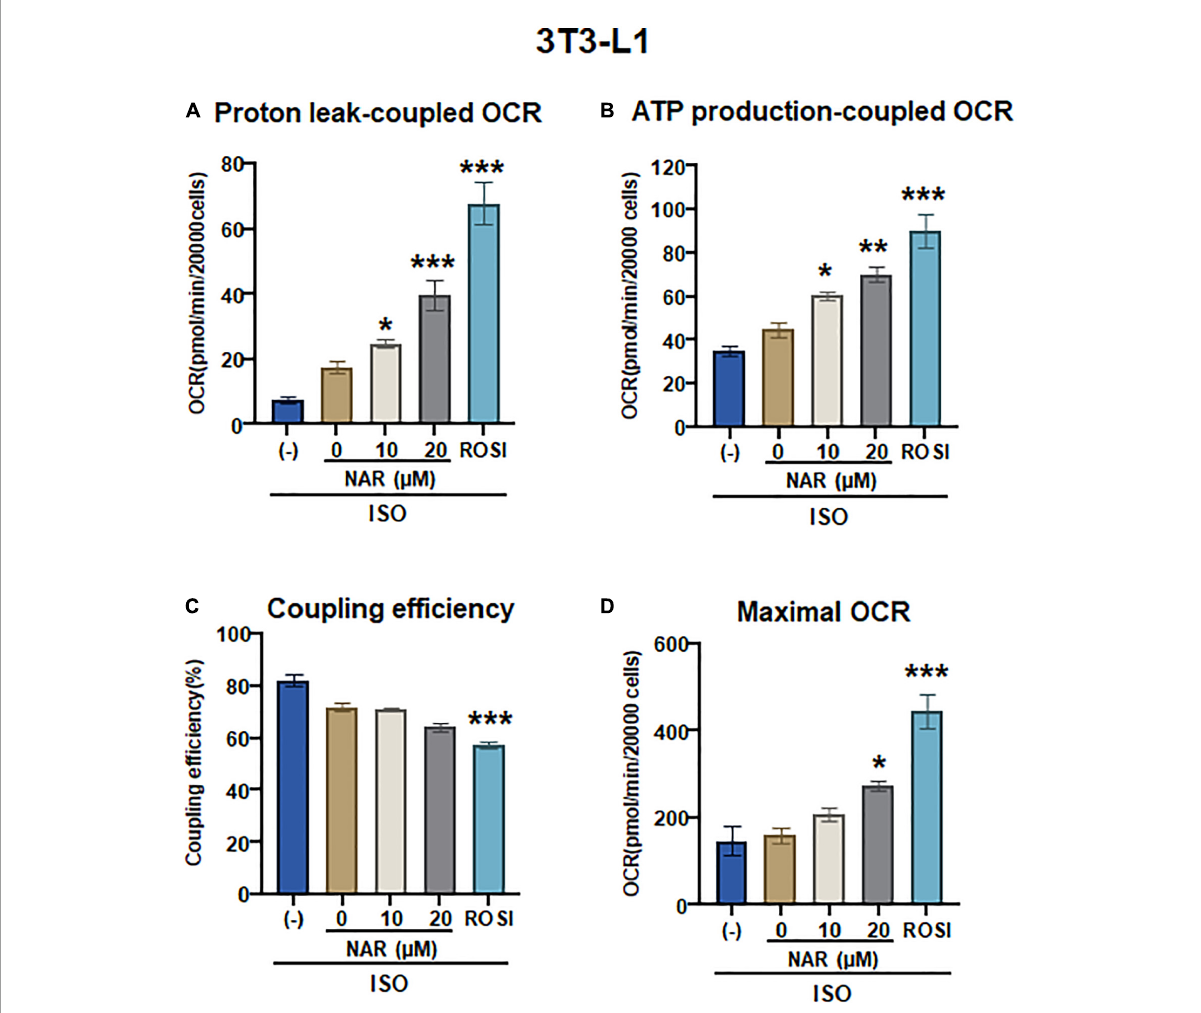
FIGURE5 Naringenin enhances mitochondrial respiration and uncoupling in isoproterenol (ISO)-stimulated 3T3-L1 adipocytes. (A–D) 3T3-L1 cells were differentiated in the presence or absence of NAR (10 and 20 µ M) or ROSI (1 µ M) for 6 days. Then the cells were reseeded at 20,000 per well into an XFe24 assay plate. After 24 h, the cells were subjected to real-time OCR measurements using an XFe24 Extracellular Flux Analyzer. ISO was injected after three basal OCRs were taken, followed by oligomycin, FCCP, and rotenone/antimycin A injections as described. OCR linked to proton leak (A) and ATP production (B) , coupling efficiency (C) , and maximal respiration (D) were calculated and presented. Data = Mean ± SEM ( n = 3–7). *, **, *** p < 0.05, p < 0.01, and p < 0.001 compared to the 0 µ M NAR sample,